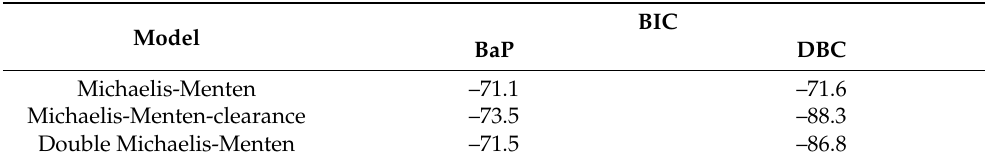
Figure 2. Rates of benzo[a]pyrene (BaP; ( A )) and dibenzo[def,p]chrysene (DBC; ( B )) disappearance in human hepatic microsomes at different substrate concentrations. Lines are best fit models describing the metabolism. Table 2. Bayesian information criteria (BIC) for metabolism model fits to rates of benzo[a]pyrene (BaP) and dibenzo[def,p]chrysene (DBC) metabolism in human hepatic microsomes at different substrate concentrations.